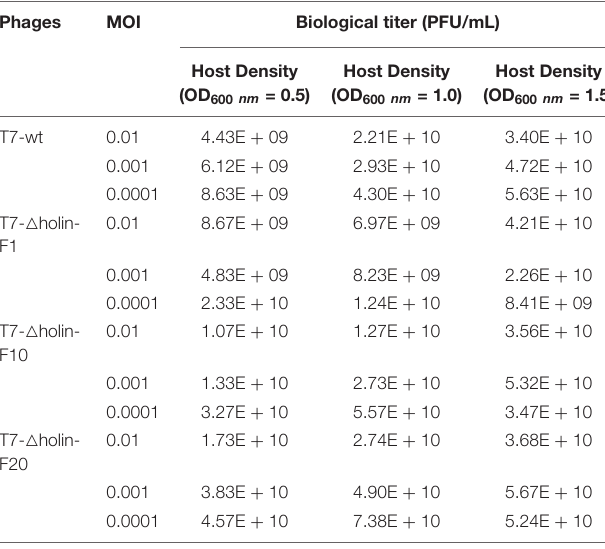
TABLE 3 | Optimization of cultivation process of T7- (cid:52) holin-infected Escherichia coli BL21 cells.